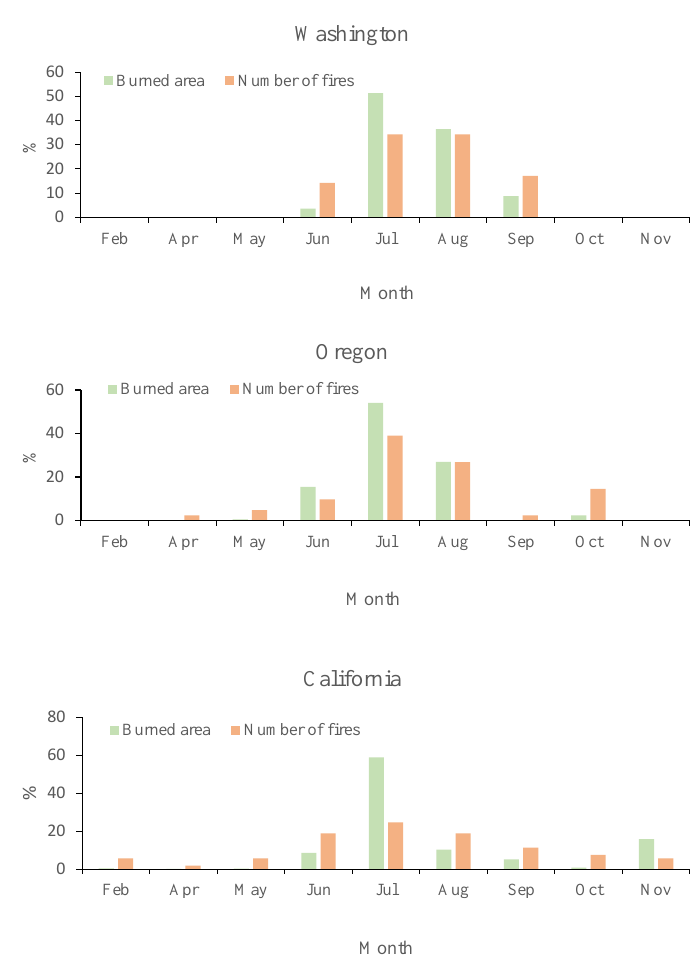
Figure 3. Percentage of monthly number of fires and hectares burned for the state of Washington, Oregon, and California in the year of 2018. Note: the ignition sources are not considered in this research.